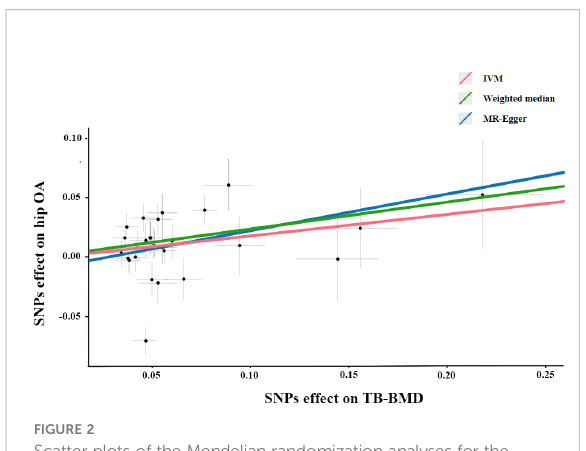
FIGURE 2 Scatter plots of the Mendelian randomization analyses for the association of TB-BMD with the risk of hip OA. The red line represents the inverse variance weighted estimate, the green line represents the Weighted median estimate, the blue line represents the MR-Egger estimate.